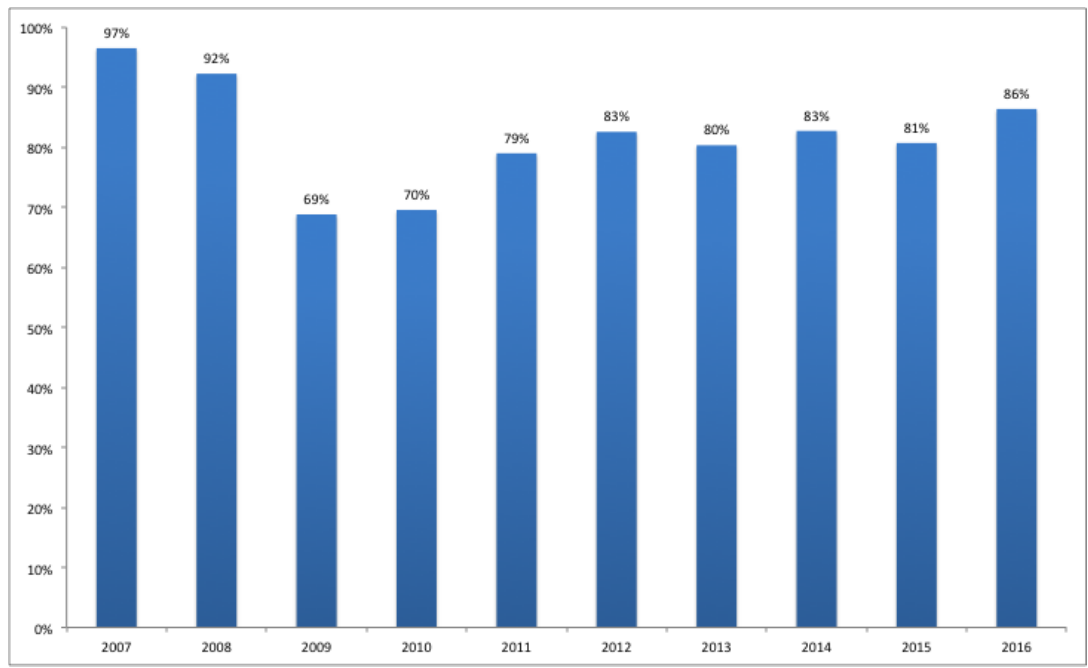
Figure 6. Durham’s debt ratio 2007 – 2016.